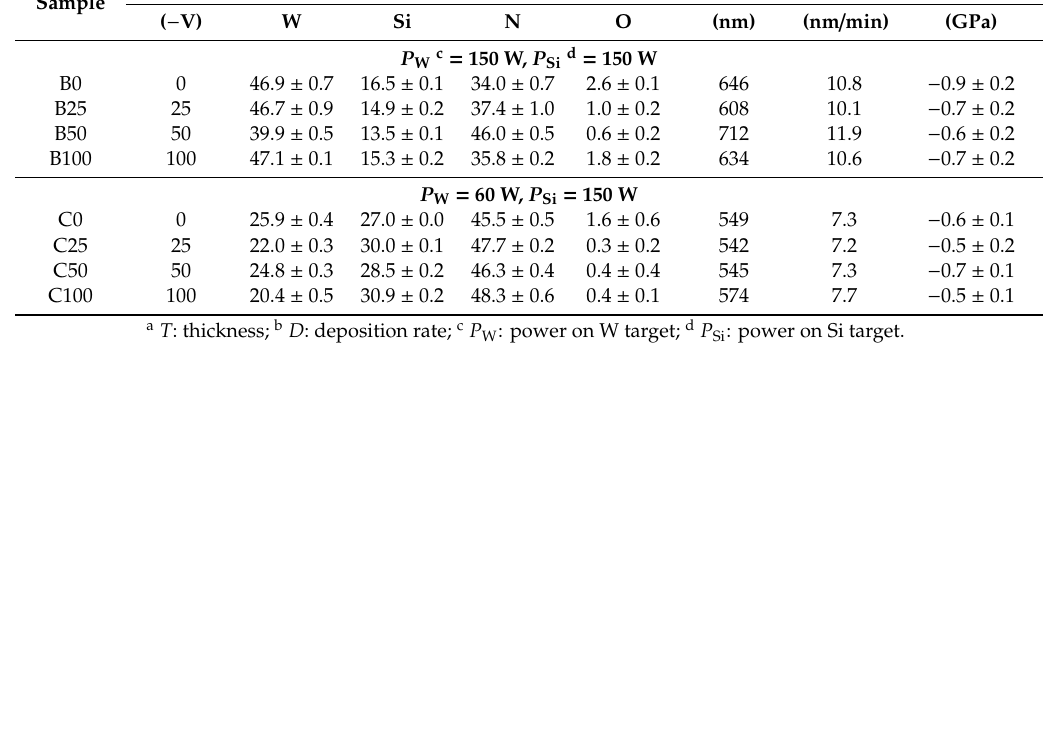
Table 4. Atomic compositions, thicknesses, and residual stresses of W–Si–N films prepared using various bias voltages. Bias Atomic Composition Sample